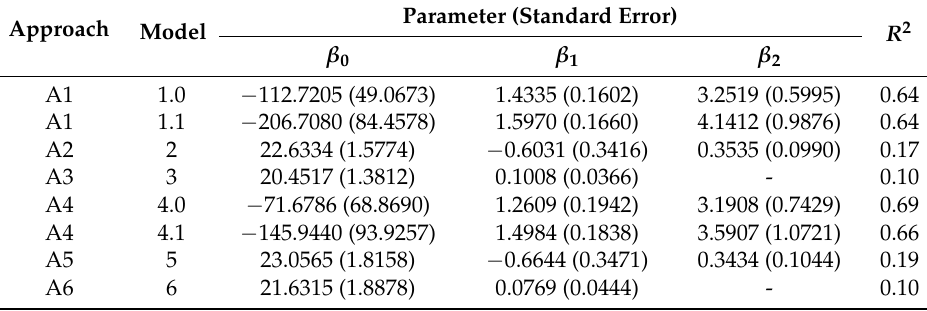
Table 2. Parameter estimates and their standard errors of the models used to predict aboveground biomass and its change using lidar variables. Model 1.0 and Model 1.1 predicted aboveground biomass per hectare in 2007 and 2012, respectively, using the fixed effects model. Model 4.0 and 4.1 did the same based on the mixed effects model. All other models predicted the change in aboveground biomass per hectare, directly. Observed values of changes were obtained based on measurements of 78 field plots.